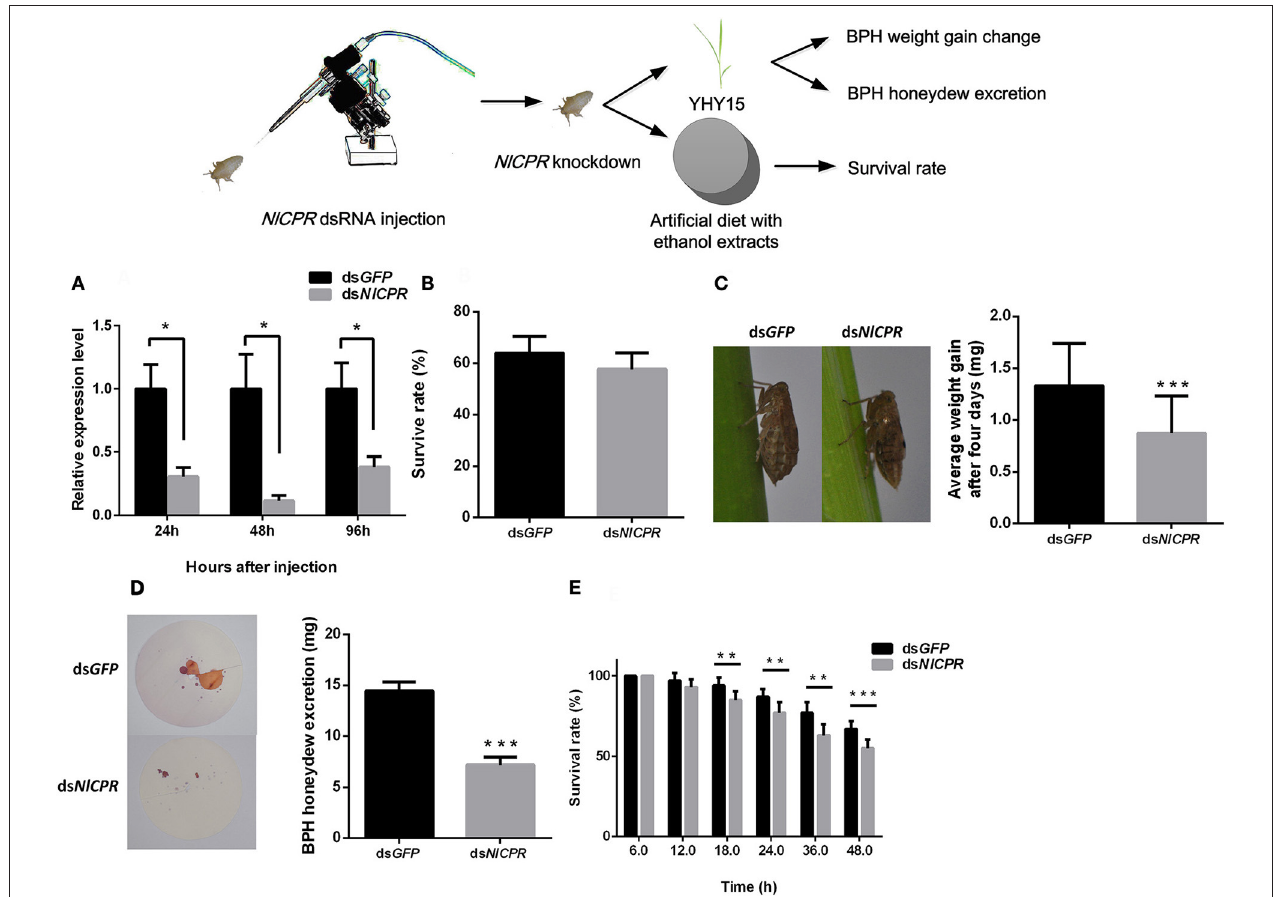
FIGURE 2 | Phenotype resulting from biotype Y BPH NlCPR knockdown. (A) qRT-PCR analysis of the effects of NlCPR knockdown at different time points. (B) Survival rates of biotype Y BPHs treated with NlCPR and GFP dsRNA. GFP dsRNA-treated BPH served as the control. (C) Weight gain of dsRNA-treated BPHs. (D) Honeydew excretion by dsRNA-treated BPHs. (E) Survival rates of BPHs fed artificial diets containing 10% ethanol extracts. *, **, *** on the bars indicate significance at P < 0.05, P < 0.01, and P < 0.0001 ( t -test),